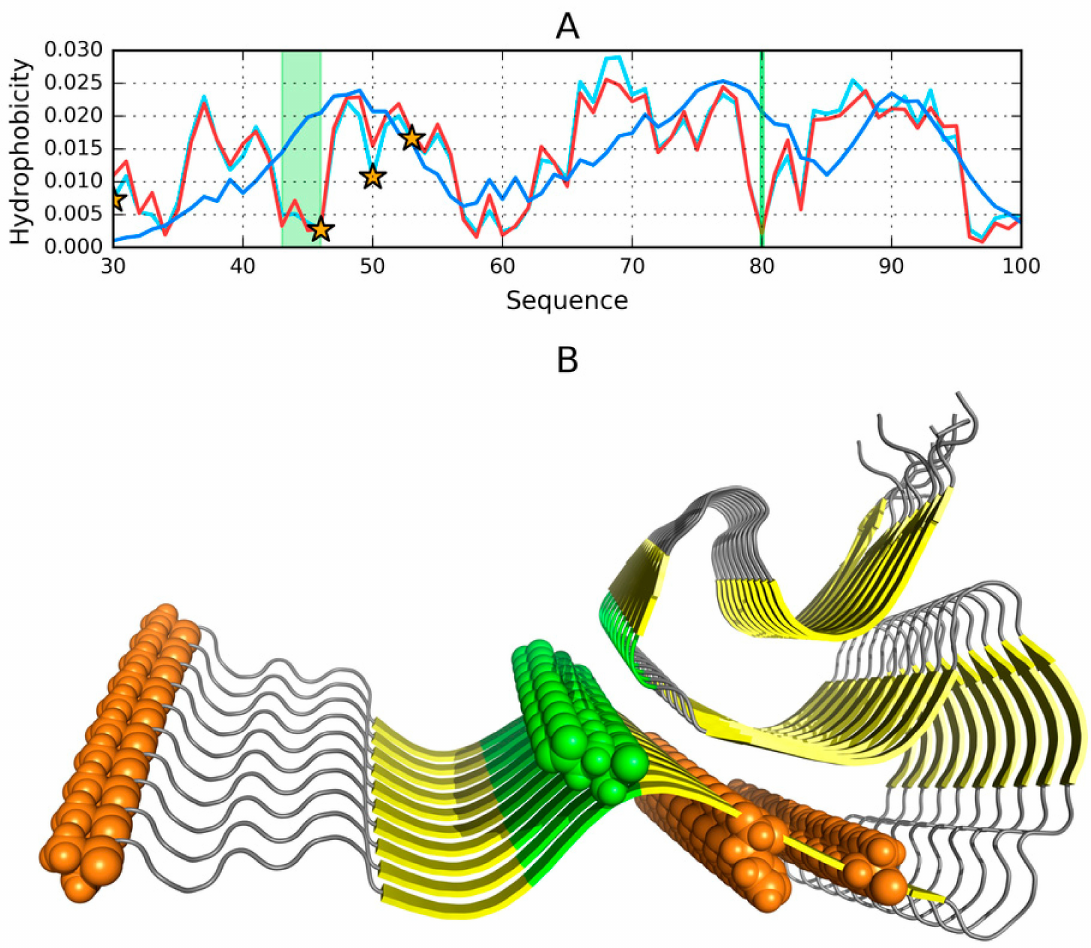
Figure 9. Presentation of the fibrillar part (30–100) of ASyn (2N0A); ( A )—Theoretical (T, blue) and observed (O, red) hydrophobicity density distribution profiles for chain E. The teal chart represents the observed profile for the mutated sequence; ( B )—3D visualization; Orange stars in Figure 9A, and orange / green spheres in Figure 9B correspond to loci of mutations which lower intrinsic hydrophobicity: A30P, E46K, H50Q and A53T. Green fragments correspond to residues No. 43–46 and 80, which–when eliminated from FOD computations—Produce a distribution consistent with the theoretical model ( RD lowered from 0.506 to